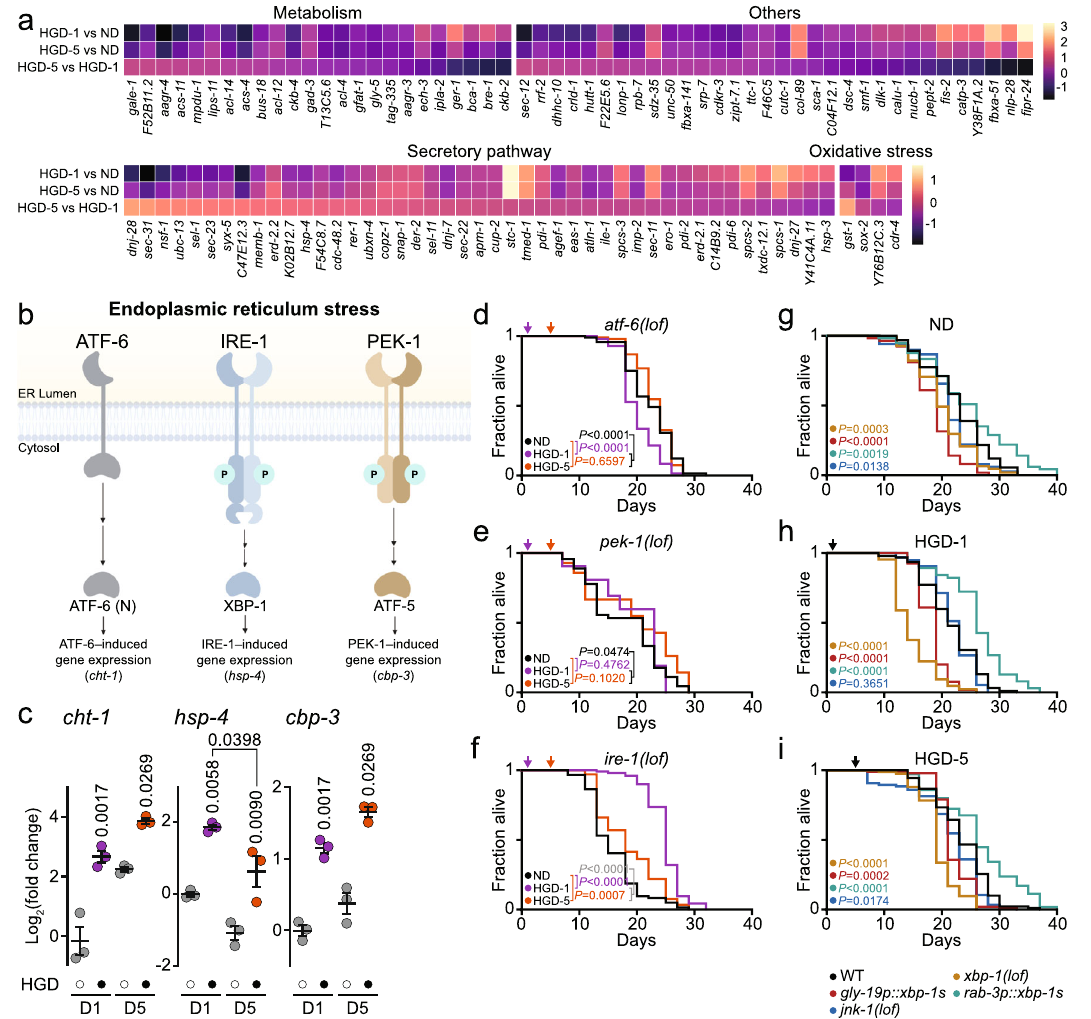
Fig. 6 | The UPR responsiveness is remodelled in aged worms extending life- span upon HGD. a Differentially expressed genes related to the UPR comparing each diet group with one another. b Overview of the unfolded protein response (UPR) in C.elegans . Created with BioRender.com. c qPCR comparing expressionof genes cht-1 , hsp-4 ,and F40F12.7 induced from UPRbranches ATF-6, IRE-1, and PEK- 1,respectively,in1-and5-day-oldWTwormsfed24hnormaldiet(ND,opencircles) or high glucose diet (HGD, fi lled circles). Data shown are the mean±SEM ( n =3). d – g Lifespan assayof 1- and 5-day-old atf-6(lof) (ND, n =287; HGD-1, n =99; HGD-5,